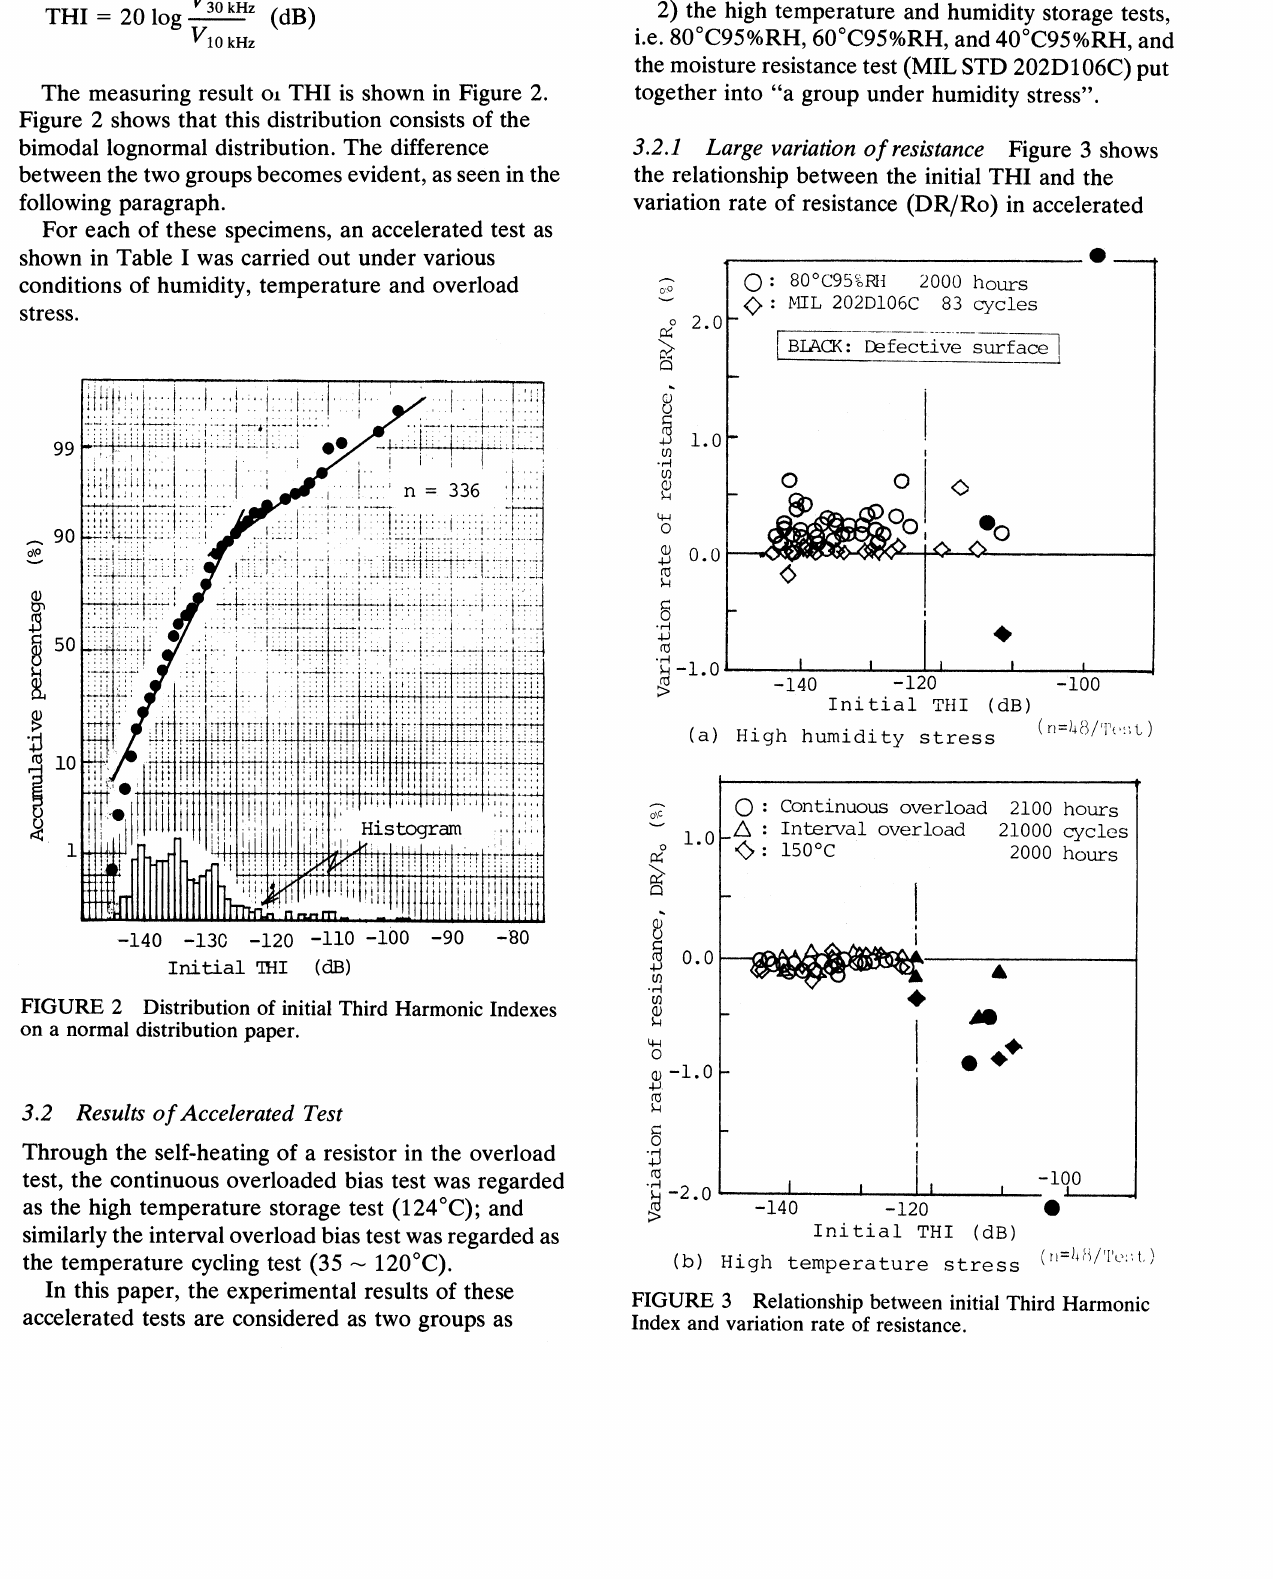
FIGU 2 Distribution of initial Third Harmonic Indexes on a normal distribution paper.